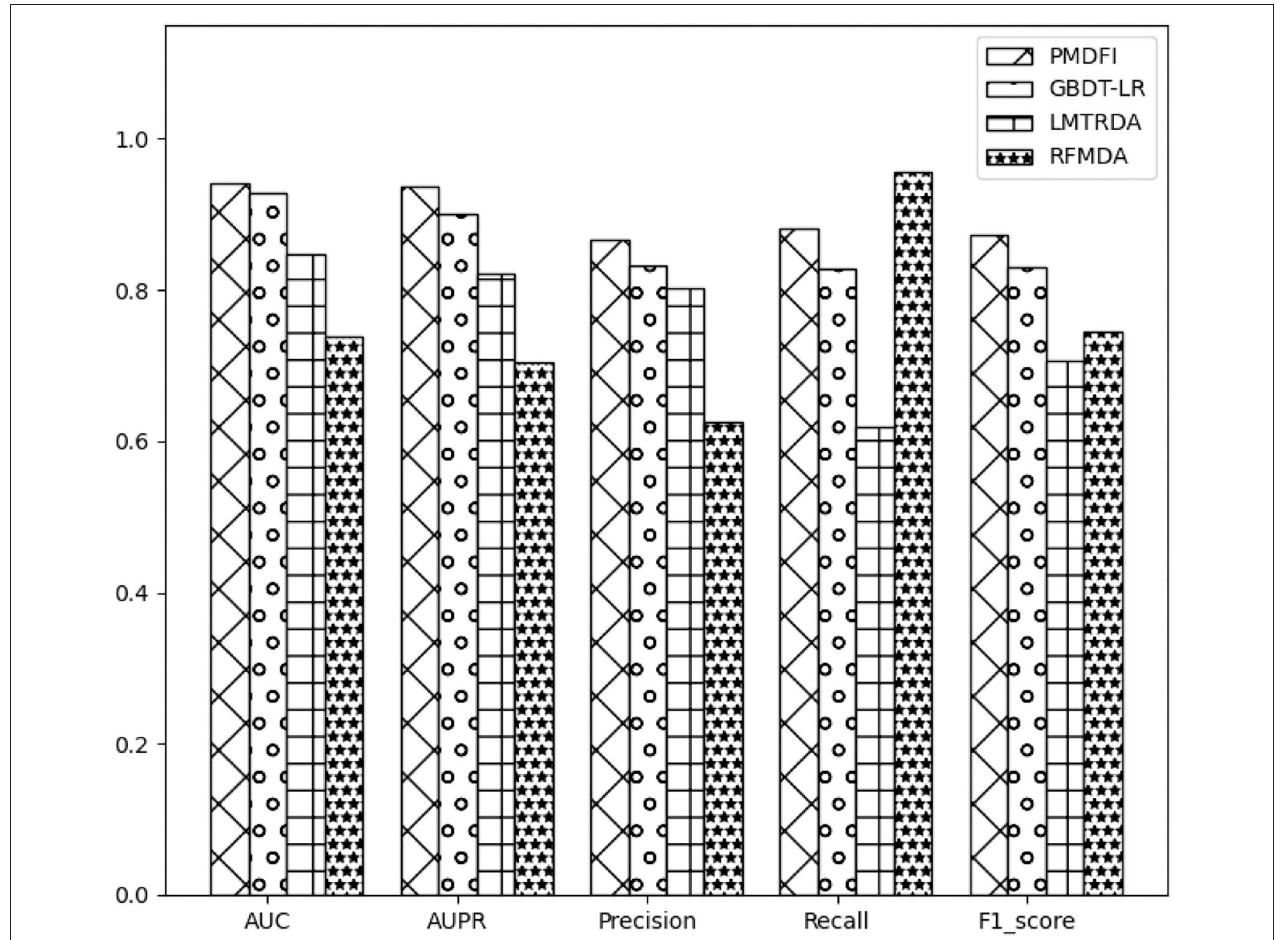
FIGURE 3 | Histograms of the results of different methods based on 5-fold cross-validation.